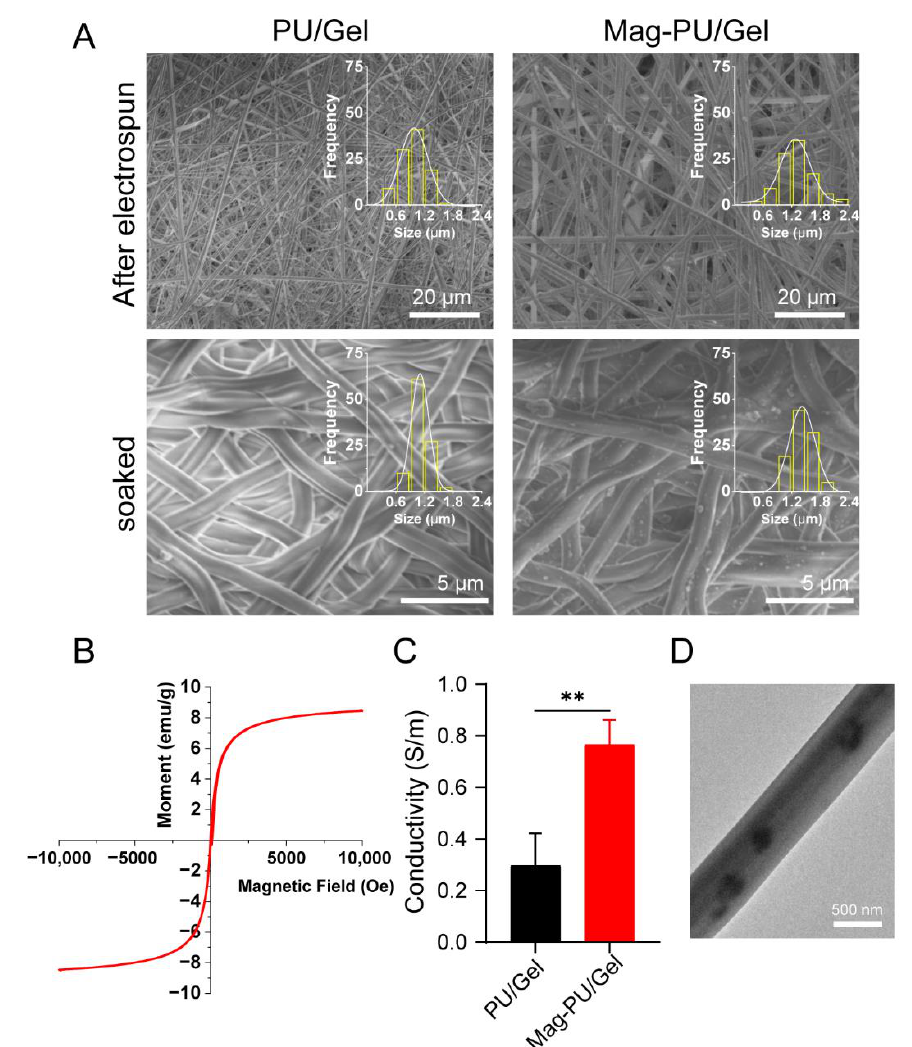
Figure 1. Characterizations of electrospun superparamagnetic fibrous scaffolds. ( A ) SEM images of different scaffolds. ( B ) Magnetization curve of Mag-PU/Gel. ( C ) Conductivity of different scaffolds. ( D ) Representative TEM image of the nanofibers of Mag-PU/Gel. These data were analyzed with two-tailed Student’s t -test: ** p < 0.01. * indicated significant difference.